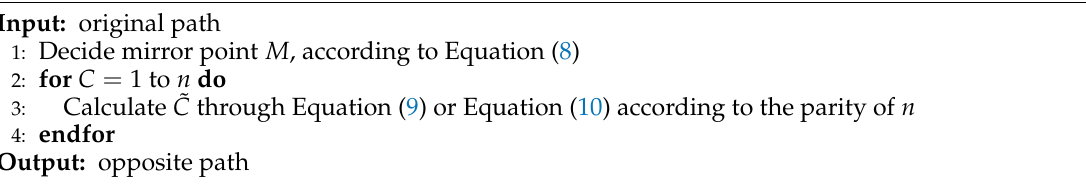
Algorithm 4 Constructing the opposite path based on the mirror